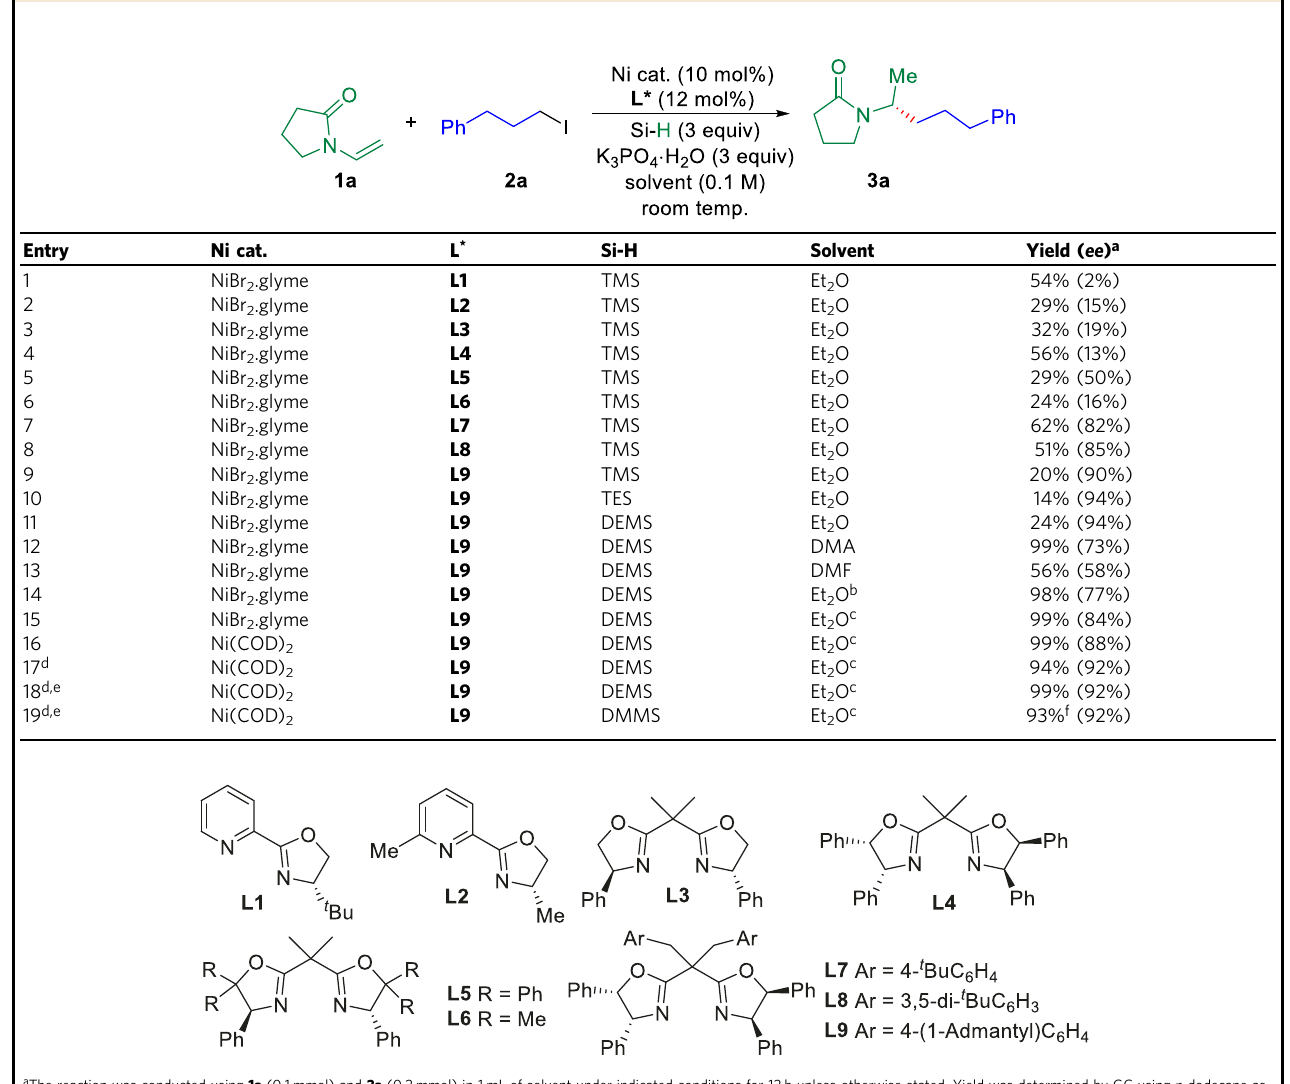
Table 1 Condition evaluation of the